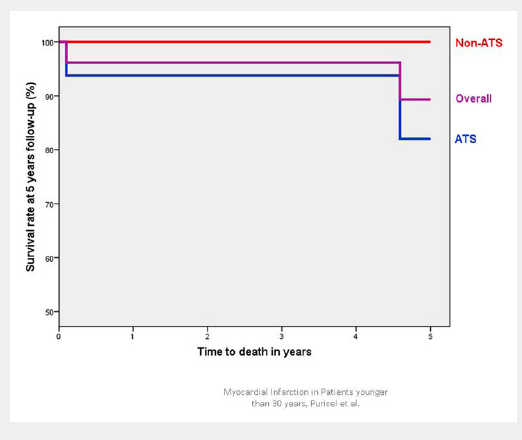
Cumulative survival in patients <30 years presenting with acute coronary syndrome. ATS = atherosclerosis; non-ATS = patients without angiographic evidence of